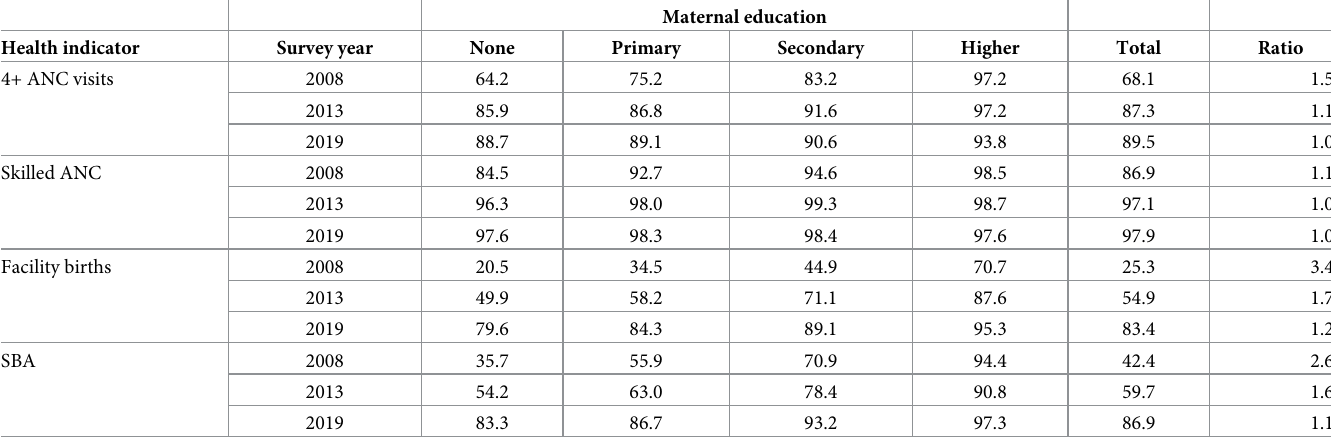
Table 2. Maternal health indicators by maternal education in 2008, 2013 and